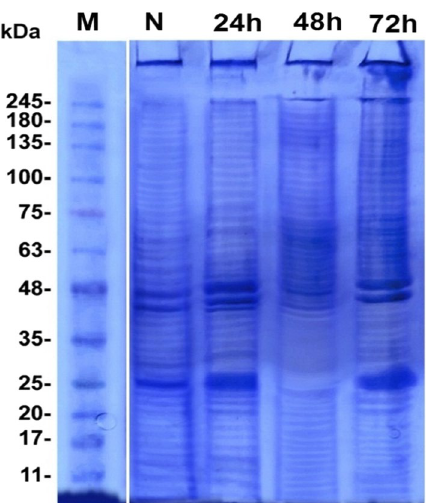
Fig. 5 Electrophoretically separated hemolymph Protein bands of full grown larval instar Corcyra cephalonica of Unparasitized and Parasitized larvae by natural envenomation of Bracon hebetor at Consecutive period of parasitism. Separated using SDS‑ PAGE (10%). MW: Wide range molecular weight marker (245–11 kDa). Equivalent protein amounts of 20 μg/lane were loaded. lane1: Marker of protein; lane 2: (N) Normal hemolymph of Corcyra cephalonica larvae; lane 3: hemolymph after 24 h post‑parasitism; lane 4: hemolymph after 48 h post‑parasitism; lane 5: hemolymph after 72 h